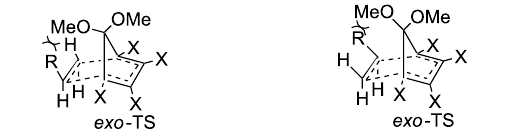
Figure 2: 1 H NMR chemical shifts (in parentheses) and coupling constants ( J ) for the three interacting protons (H 5 , H 6 , and H 6’ ; for the sake of convenience, numbering sequence of mono-adducts is adopted) of the bis-adducts 6 and 13 .